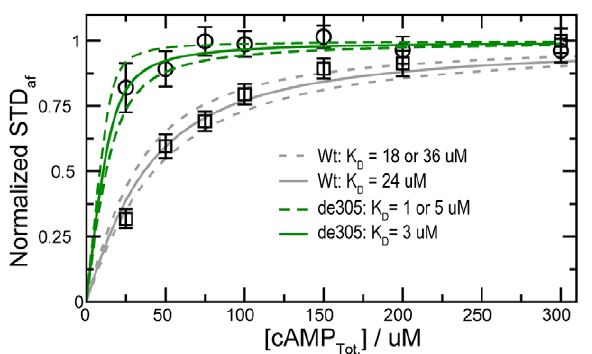
Figure 6. Binding isotherms for the titration of cAMP into an NMR sample with 15 m M de305 (green) and 25 m M Wt (grey) in 20 mM phosphate buffer, pH 7.6, 50 mM NaCl, 99.9% D 2 O, and at 25 6 C. The binding of cAMP to de305 and Wt was monitored through the STD amplification factor (STDaf) normalized to the plateau value and plotted versus the total cAMP concentration. The binding of cAMP to the Wt construct, Epac1 149–318 was measured here to ensure an unbiased comparison to de305 since previous measurements [22,34] were on Epac1 149–317 and used different experimental conditions and